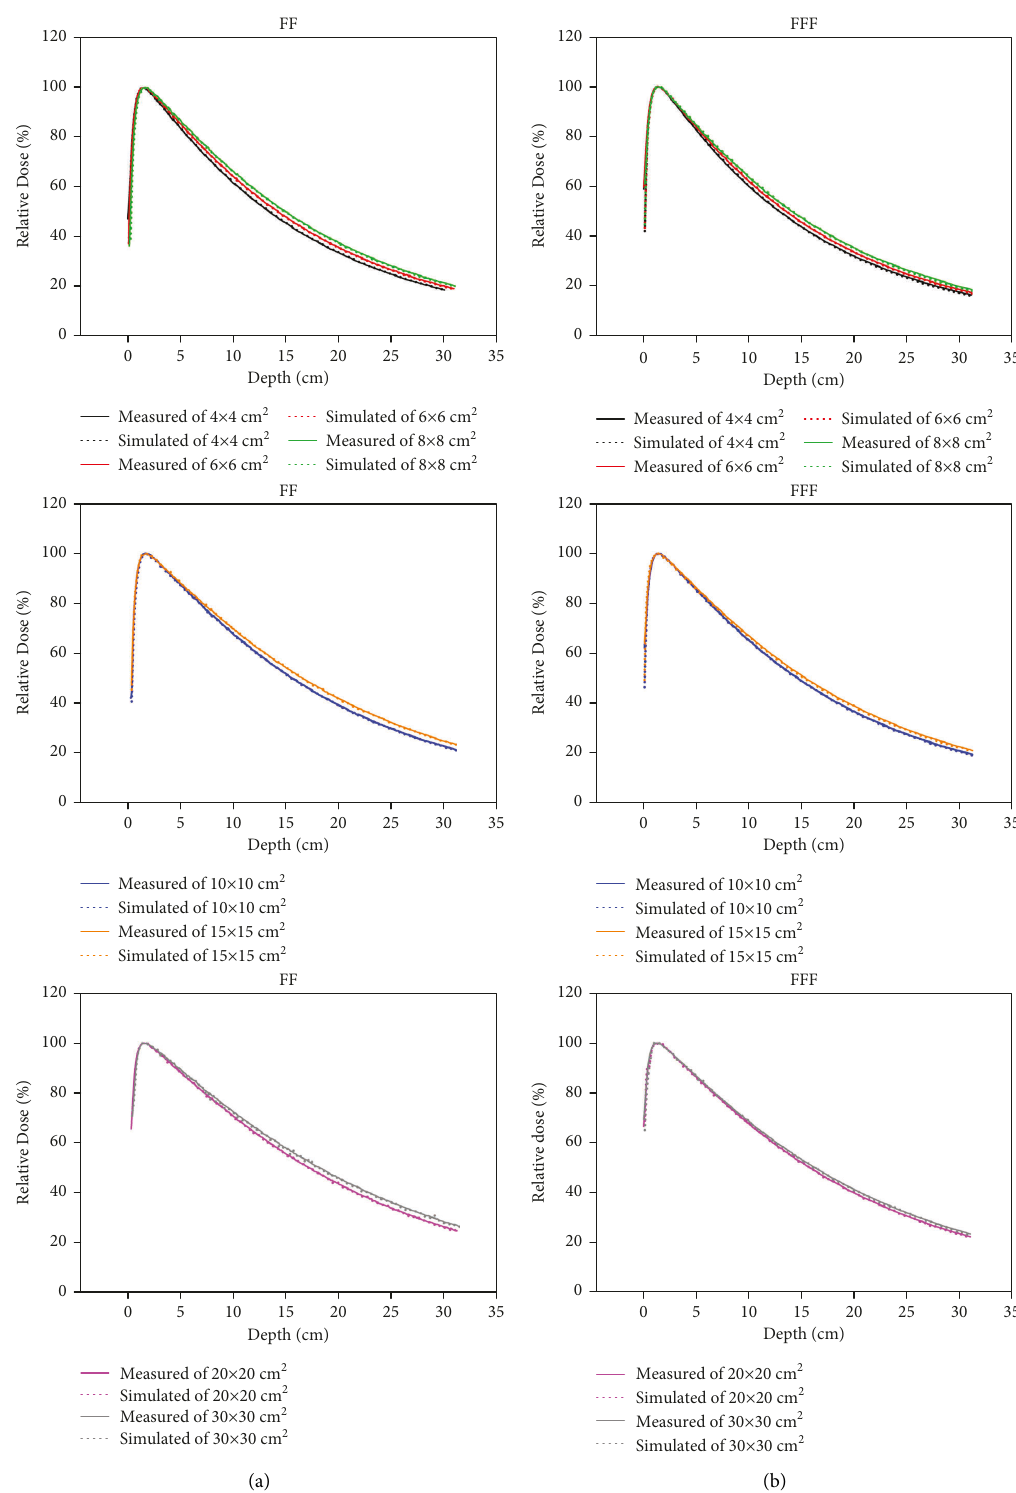
Figure 7: (a) The comparison of measured and simulated PDDs for various field sizes (cm 2 ) of 6 MV FF beams. (b) The comparison of measured and simulated PDDs for various field sizes (cm 2 ) of 6MV FFF beams. All curves are normalized to the depth of the respective maximum dose. In order to show the contrast more clearly, the seven fields are split into three panels. 4 × 4, 6 × 6, 8 × 8, 10 × 10, 15 × 15, 20 × 20, 30 × 30cm 2 fields are shown in order by black, red, green, blue, orange, pink, and gray curves. Solid lines represent measured data and dotted lines represent simulated